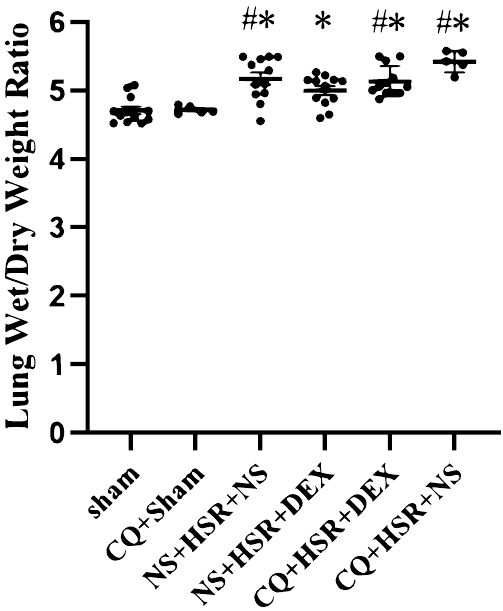
Figure 3. Effect of dexmedetomidine (DEX) administration on lung edema after hemorrhagic shock resuscitation (HSR). Effects of DEX on HSR-induced lung wet/dry weight ratio. Lung wet/dry weight ratio. Twenty-four hours after HSR, the left lung of each rat was excised and weighed (wet weight), placed in a 110 °C environment to dry for 24 h, and then weighed again (dry weight). The lung wet/dry weight ratio was calculated by dividing the wet weight of the lung by the dry weight to evaluate pulmonary edema in HSR rats. Statistical analysis was performed using ANOVA followed by the Tukey–Kramer multiple-comparison test between groups. * p < 0.05 (vs. sham) # p < 0.05 (vs. NS + HSR +